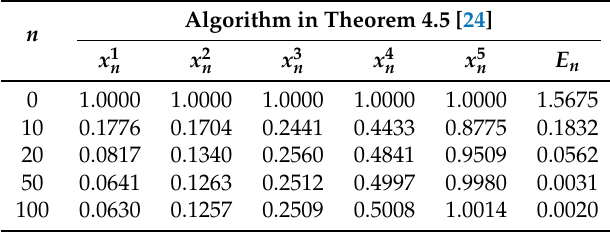
Table 2. Numerical results as regards Theorem 4.5